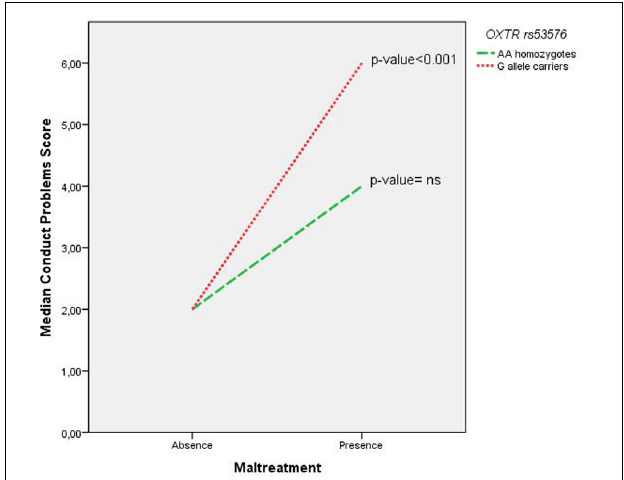
FIGURE 1 | Interpretation of the significant interaction of OXTR rs53576 and maltreatment on median conduct problems score ( p = 0.009) among females with follow-up analysis. In the absence of maltreatment there was no genotype effect. Among G allele carriers, there was a significant increase in median conduct problems score as a function of maltreatment ( p < 0.001), whereas among AA homozygotes, maltreatment did not significantly affect the median conduct problems score ( p = non-significant). The analyses were conducted with median